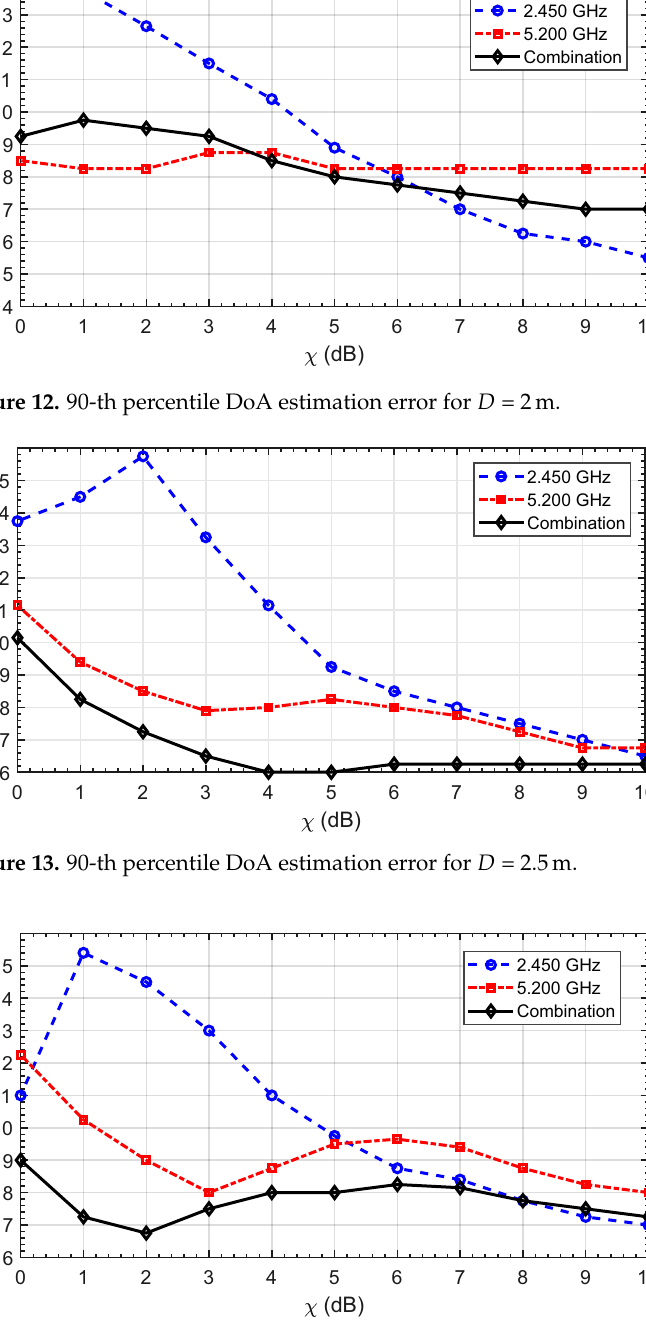
Figure 14. 90-th percentile DoA estimation error for D =